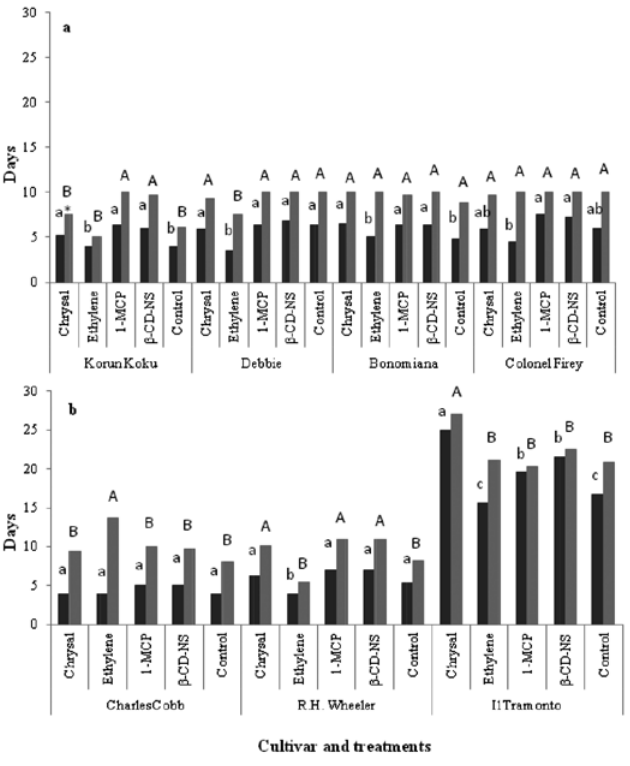
Fig. 1 - Cut flowering branch longevity of the studied Camellia ja- ponica cultivar according to five treatments and two supply chains (a. Long, b. Short). The number of days to reach the initial stage of senescence (stage 1, black bar) and complete senescence (stage 2, grey bar) was measured. Mean separation within bars of stage 1 (lower case) and stage 2 (upper case) were computed by the Ryan-Einot-Gabriel-Welsch’s multiple stepdown F (REGW-F) test, P ≤ 0.05.